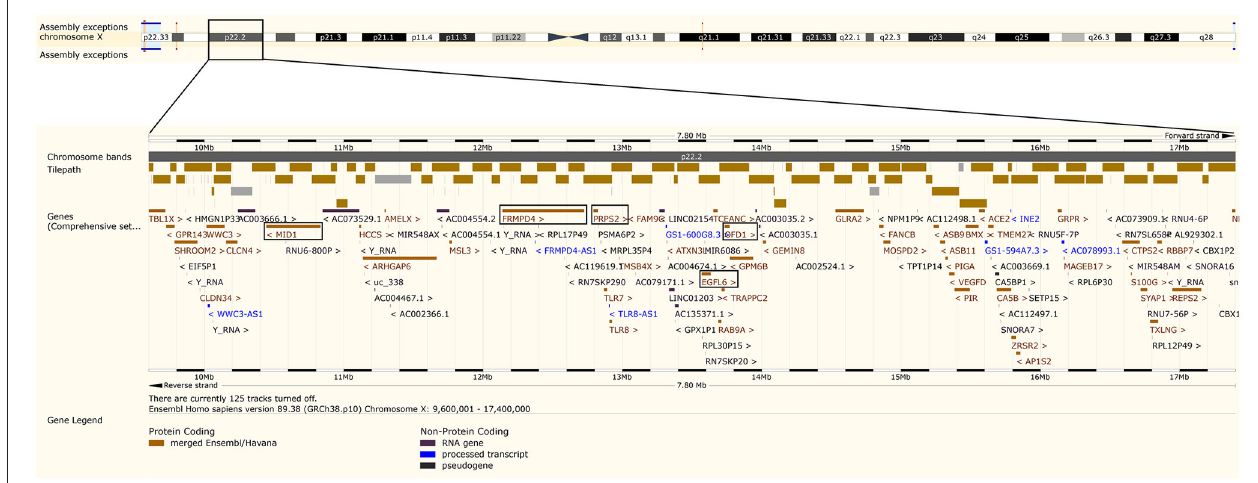
FIGURE 5 | Genes located in chromosomal region Xp22.2. This collage of screenshots of chromosomal region Xp22.2 was generated using the Ensembl genome browser (http://www.ensembl.org/) (Kersey et al., 2016; Yates et al., 2016). The three genes identified in this study are shown in boxes, in addition to the “Oral-facial-digital syndrome 1” ( OFD1 ) gene, in which we had identified associations in our previous study on candidate genes on the X chromosome ( Jugessur et al., 2012a), and the “Midline 1” ( MID1 )